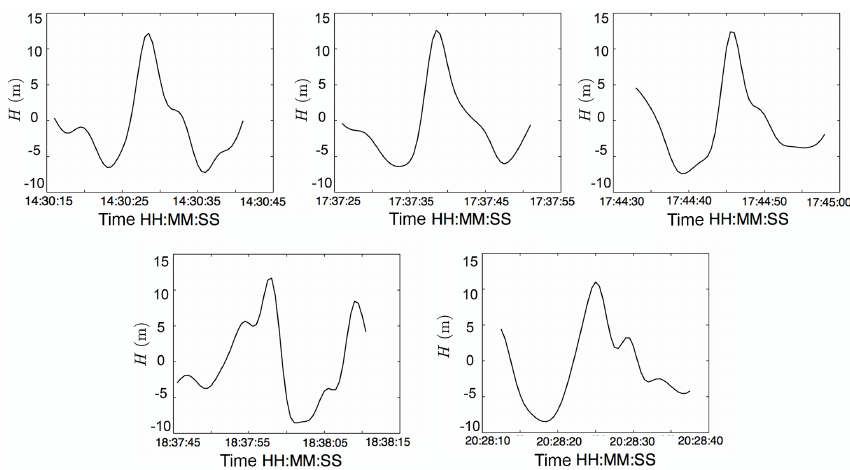
Figure 15. Large waves recorded by an ADCP near Killard, Co. Clare, on 22 February 2015.